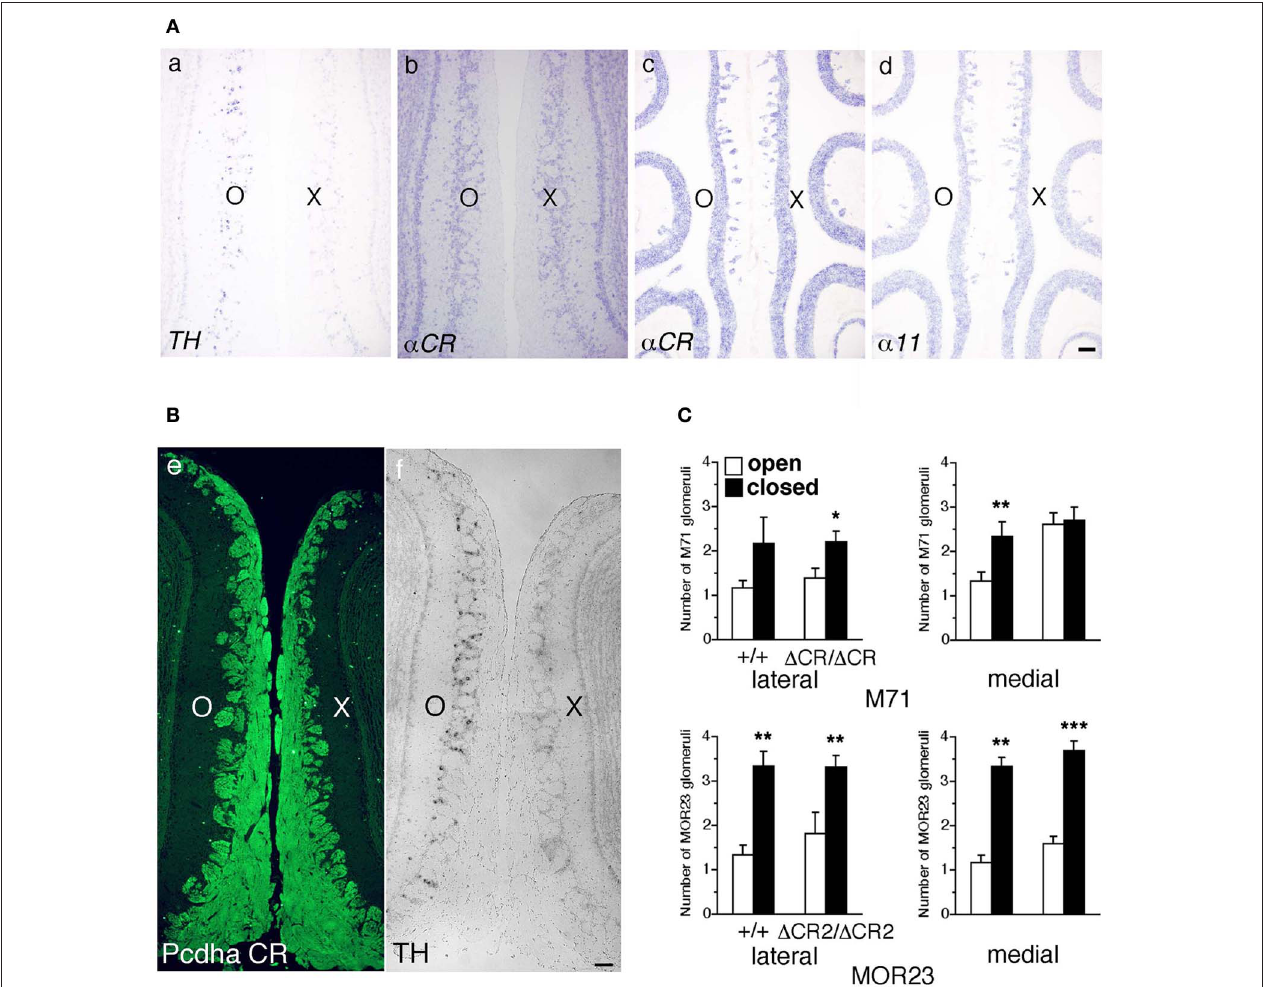
FIGURE 9 | Expression of Pcdh- α and the number of M71 and MOR23 glomeruli after naris occlusion of WT and Pcdh- α - deficient ( Pcdha (cid:2) CR /(cid:2) CR and Pcdha (cid:2) CR 2 /(cid:2) CR 2 ) mice. (A) A WT mouse was subjected to unilateral naris closure at P21 and analyzed after 1 week. The expression of tyrosine hydroxylase ( TH ) (a) and α CR transcripts (b) of the closed (X) and open (O) sides in the OB were examined by in situ hybridization histochemistry. The expression of α 11 and α CR transcripts in the OE were also examined (c, d). Scale bar, 100 μ m. (B) A WT mouse was subjected to naris occlusion at P5 and analyzed at P30. Pcdh- α immunoreactivity with the anti-Pcdh α CR antibody was strong in OSN axons and glomeruli in both the closed (X) and open (O) sides at similar levels (e), in